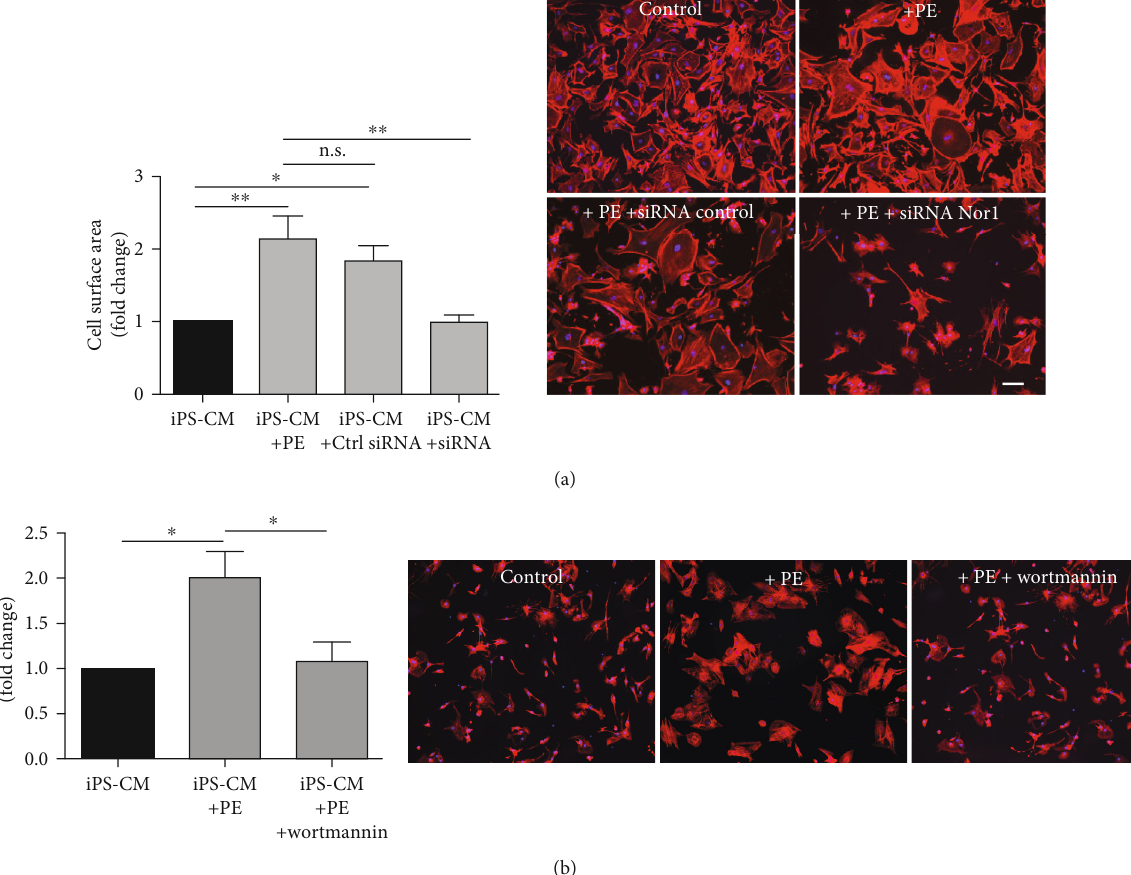
Figure 2: Suppression of Nor1 and Akt activity prevents hypertrophy induction in iPS-CM. (a) iPS-CM were seeded on fi bronectin-coated coverslips and transfected with Nor1 siRNA or control siRNA, respectively. After 24 h, cells were further treated with PE (100 μ M) to induce hypertrophy. iPS-CM cell size was quanti fi ed by histological staining of F-actin (red). n = 4 . (b) iPS-CM were treated with wortmannin (400nM) before hypertrophy induction by PE. Cell size was quanti fi ed by staining of the actin cytoskeleton. Representative images are depicted. Bar: 100 μ m. n = 4 . n.s. =not signi fi cant; ∗ p < 0 : 05 , ∗∗ p < 0 : 01